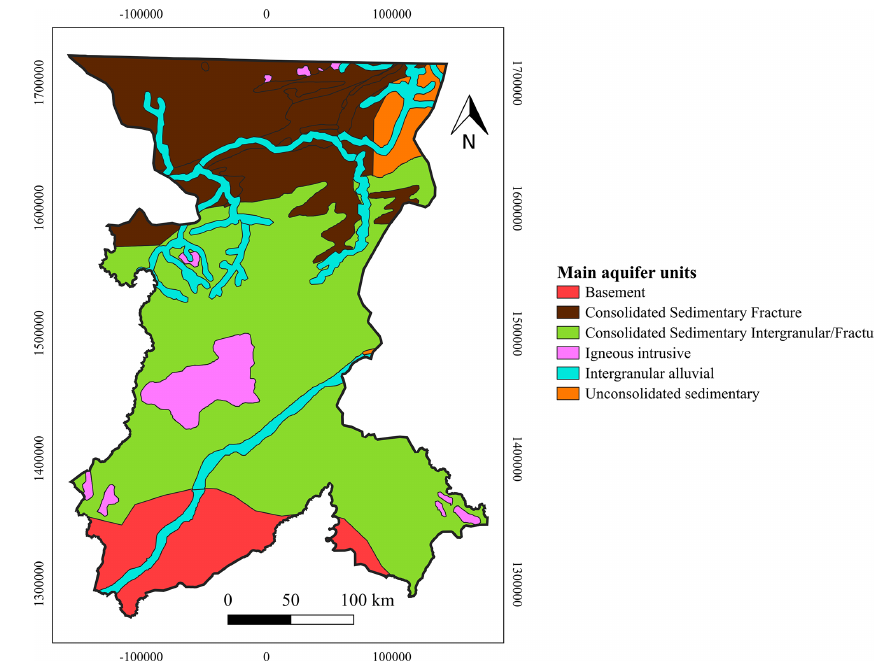
Figure 4. Main aquifer units of the study area (adapted from Traore et al.,